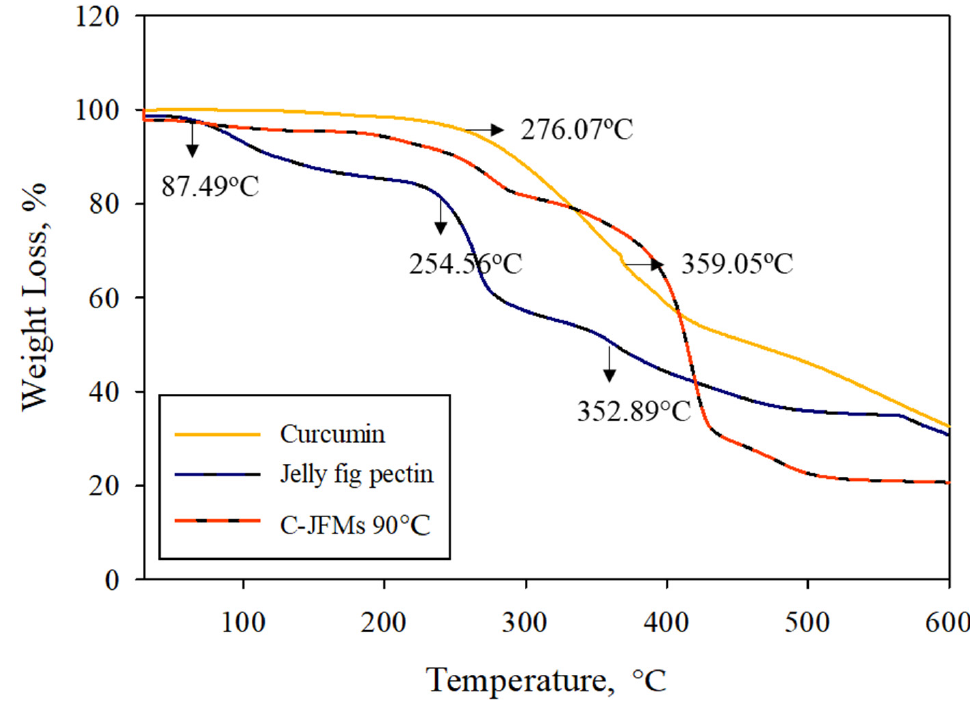
Figure 6. Thermogravimetric curves for curcumin, jelly fig, and microcapsules.